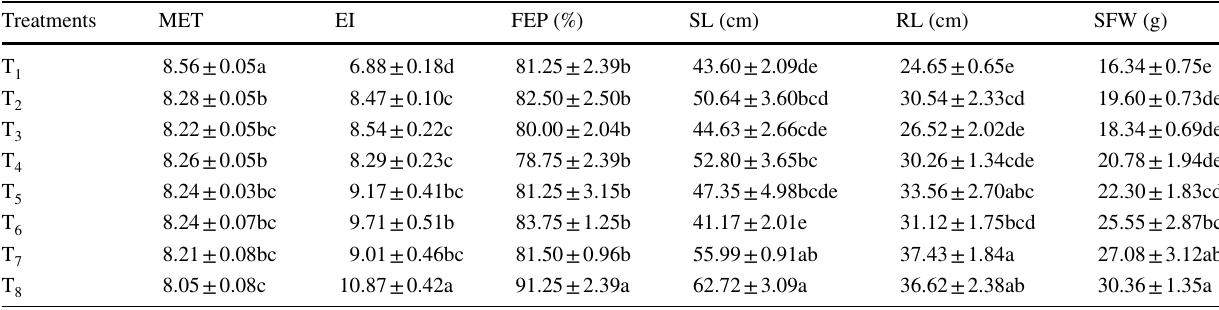
Table 2 Effect of different growing media on germination and morphological attributes of cucumber